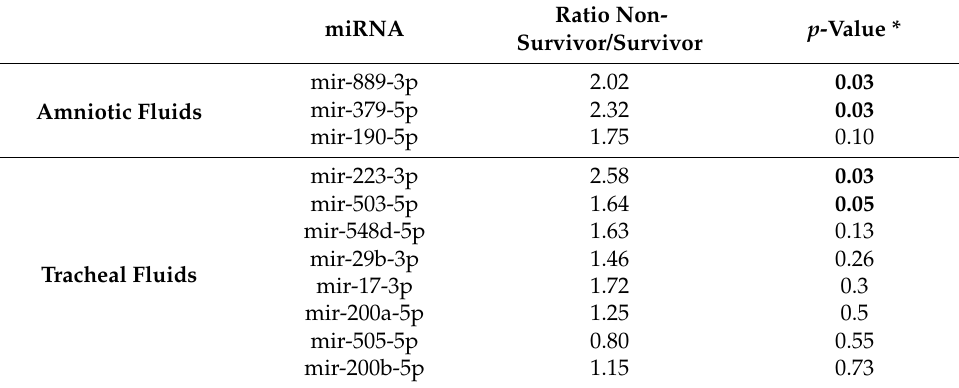
Table 4. miRNA validation in Amniotic and Tracheal Fluids.